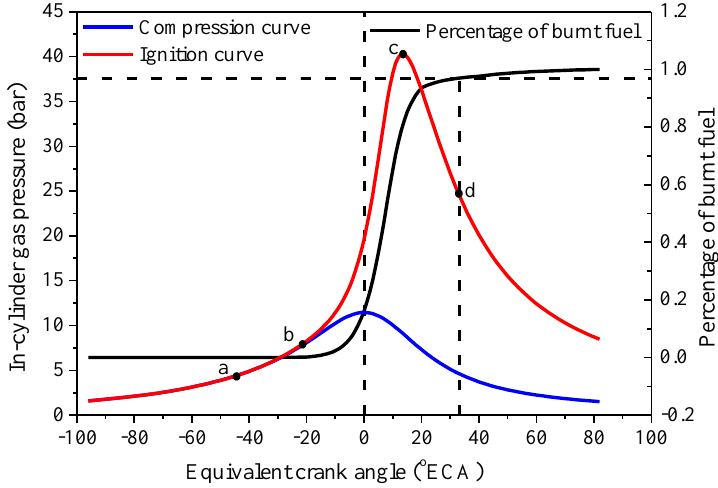
Figure 19. Combustion stage division of the FPGLG.